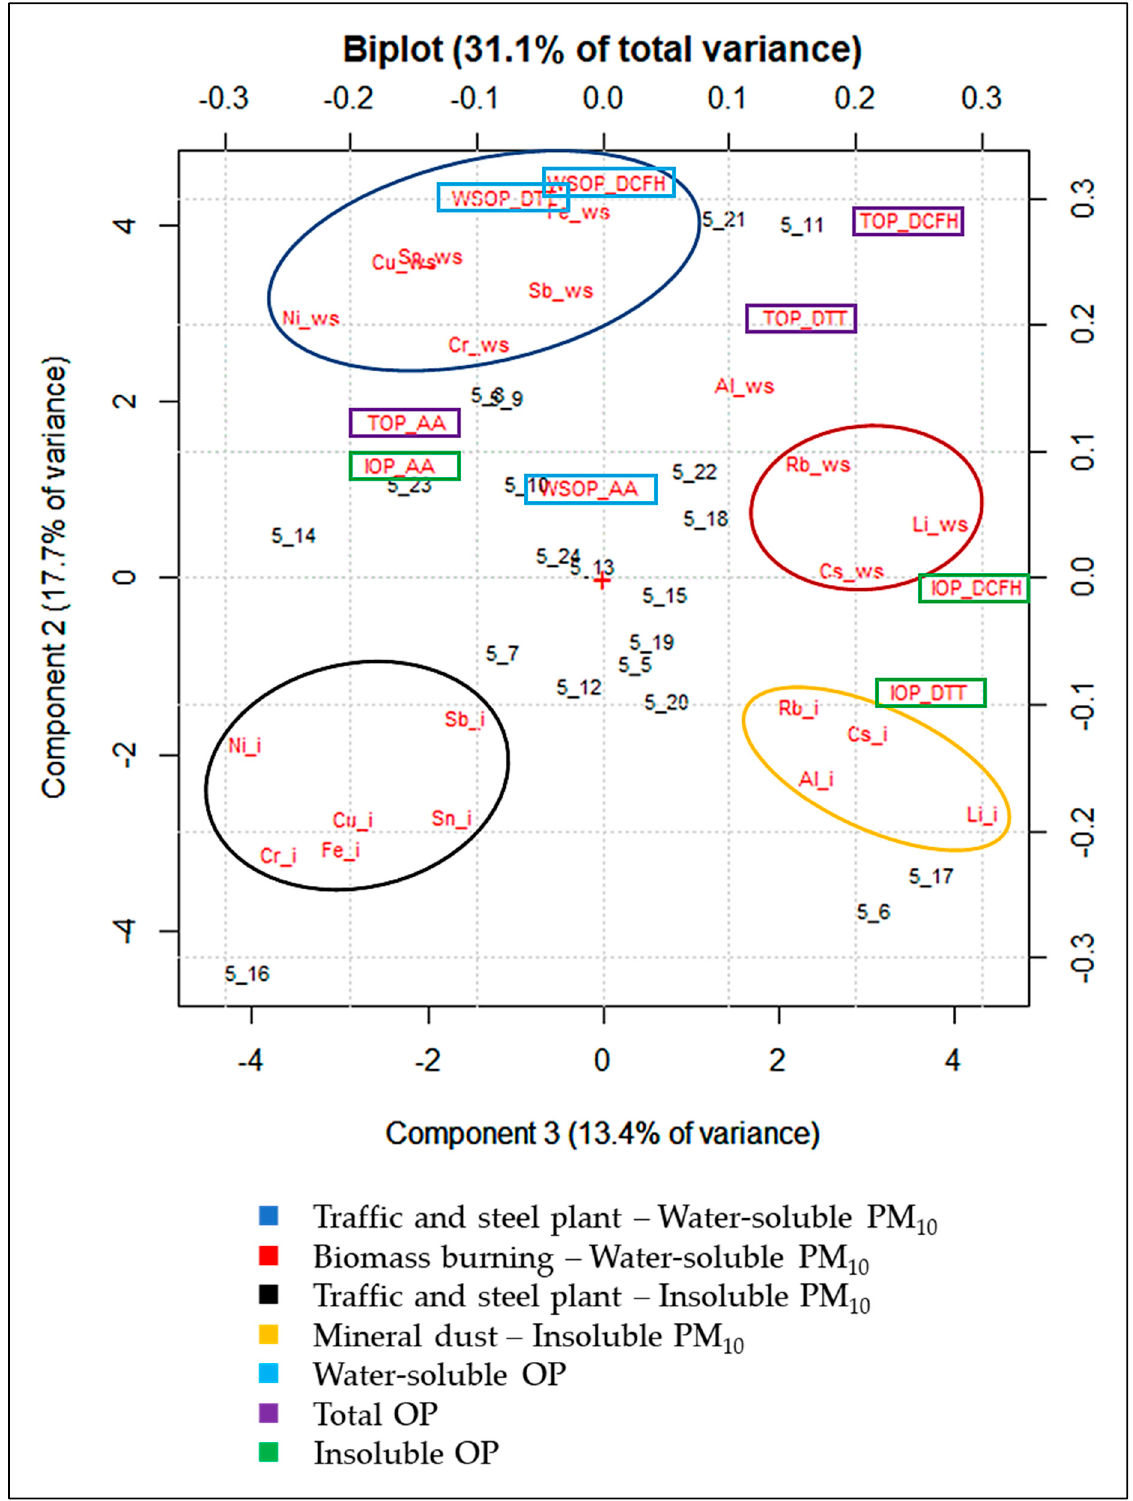
Figure 3. Biplot of PC2/PC3 from the PCA performed on the WSOP, TOP, and IOP values for OP AA , OP DTT , and OP DCFH , and element concentrations in the water-soluble (_ws) and insoluble (_i) fraction of the 20 PM 10 samples.